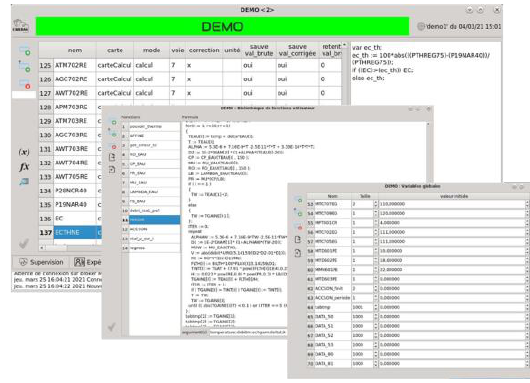
Fig. 11. Real time processing in configuration tool.